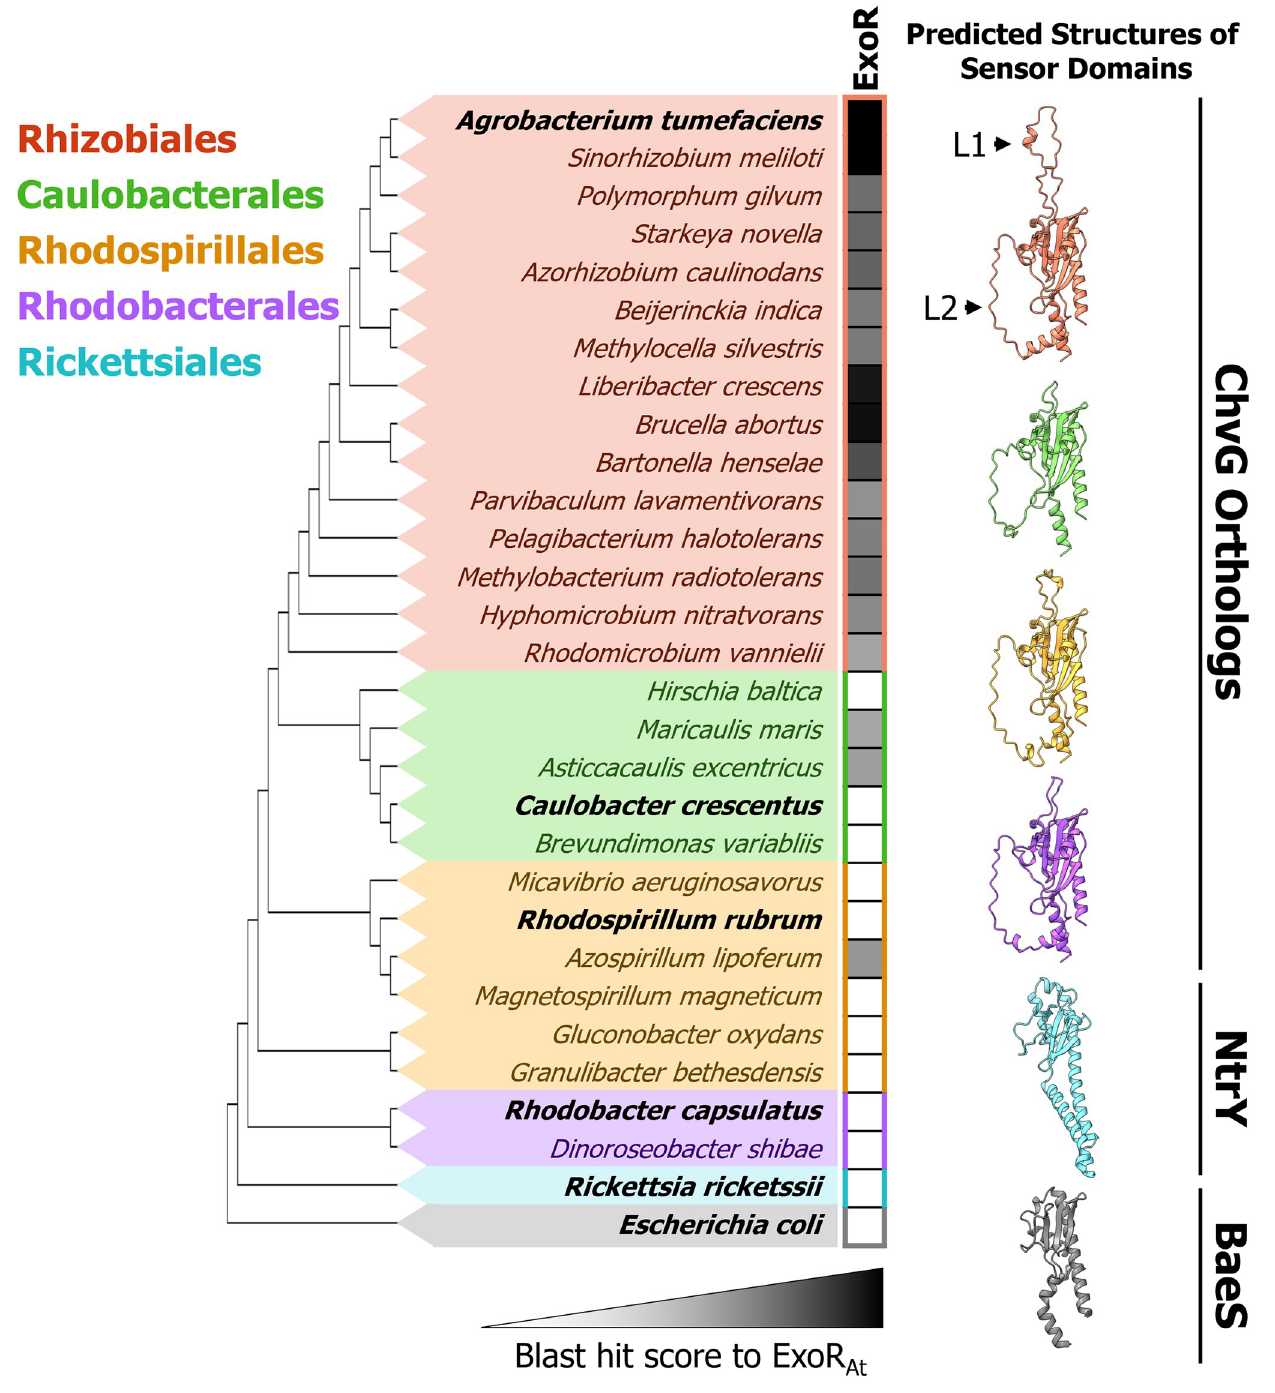
Fig 6. Conservation constraints of ExoR suggest conserved ChvG-ChvI response is independent of ExoR. Maximum parsimony tree constructed using MUSCLE sequence alignment [67] on the periplasmic regions of ChvG orthologs. In clades that don’t have a ChvG ortholog, the protein with the highest sequence similarity to ChvG was used instead. Conservation of ExoR was calculated using blast max scores from top hits when protein blasting [66] ExoR from Agrobacterium tumefaciens against each species in the tree. Phyre2 [71] predicted structures of periplasmic domains of ChvG orthologs from representatives (bold) in each genus are shown. Conserved structural loops are denoted as L1 and